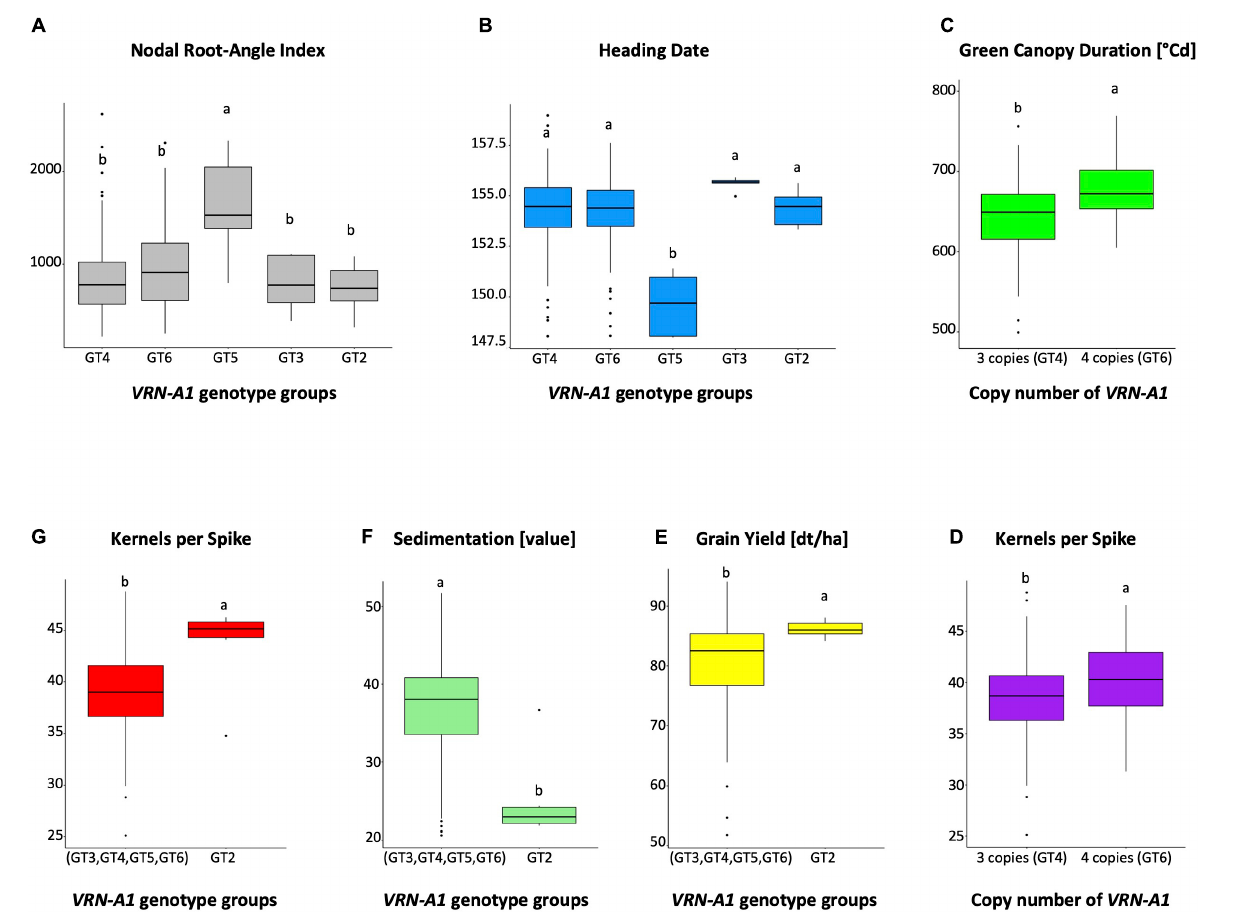
FIGURE 5 | Boxplots showing pairwise comparisons between genotype groups (A,B,E,F,G) and copy numbers (C,D) for VRN-A1 gene and different traits. Columns labeled with different letters represent significant difference at P ≤